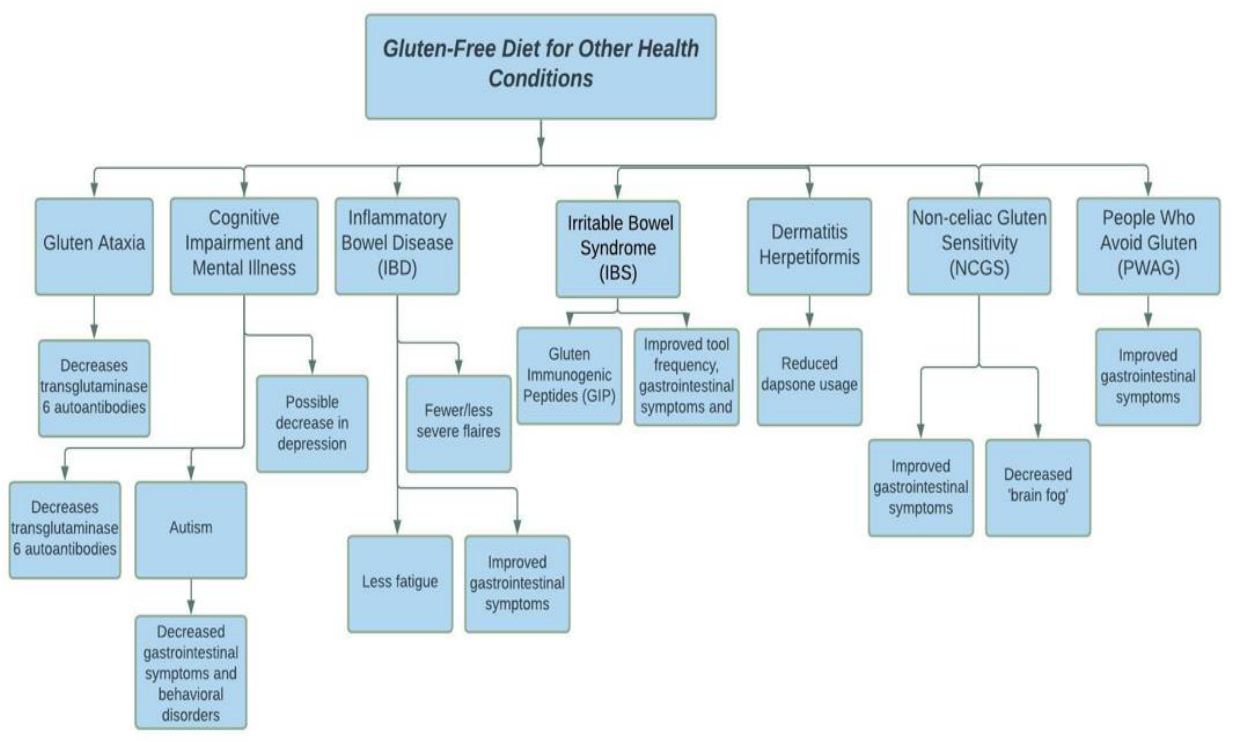
Figure 2. The GFD for health conditions other than celiac